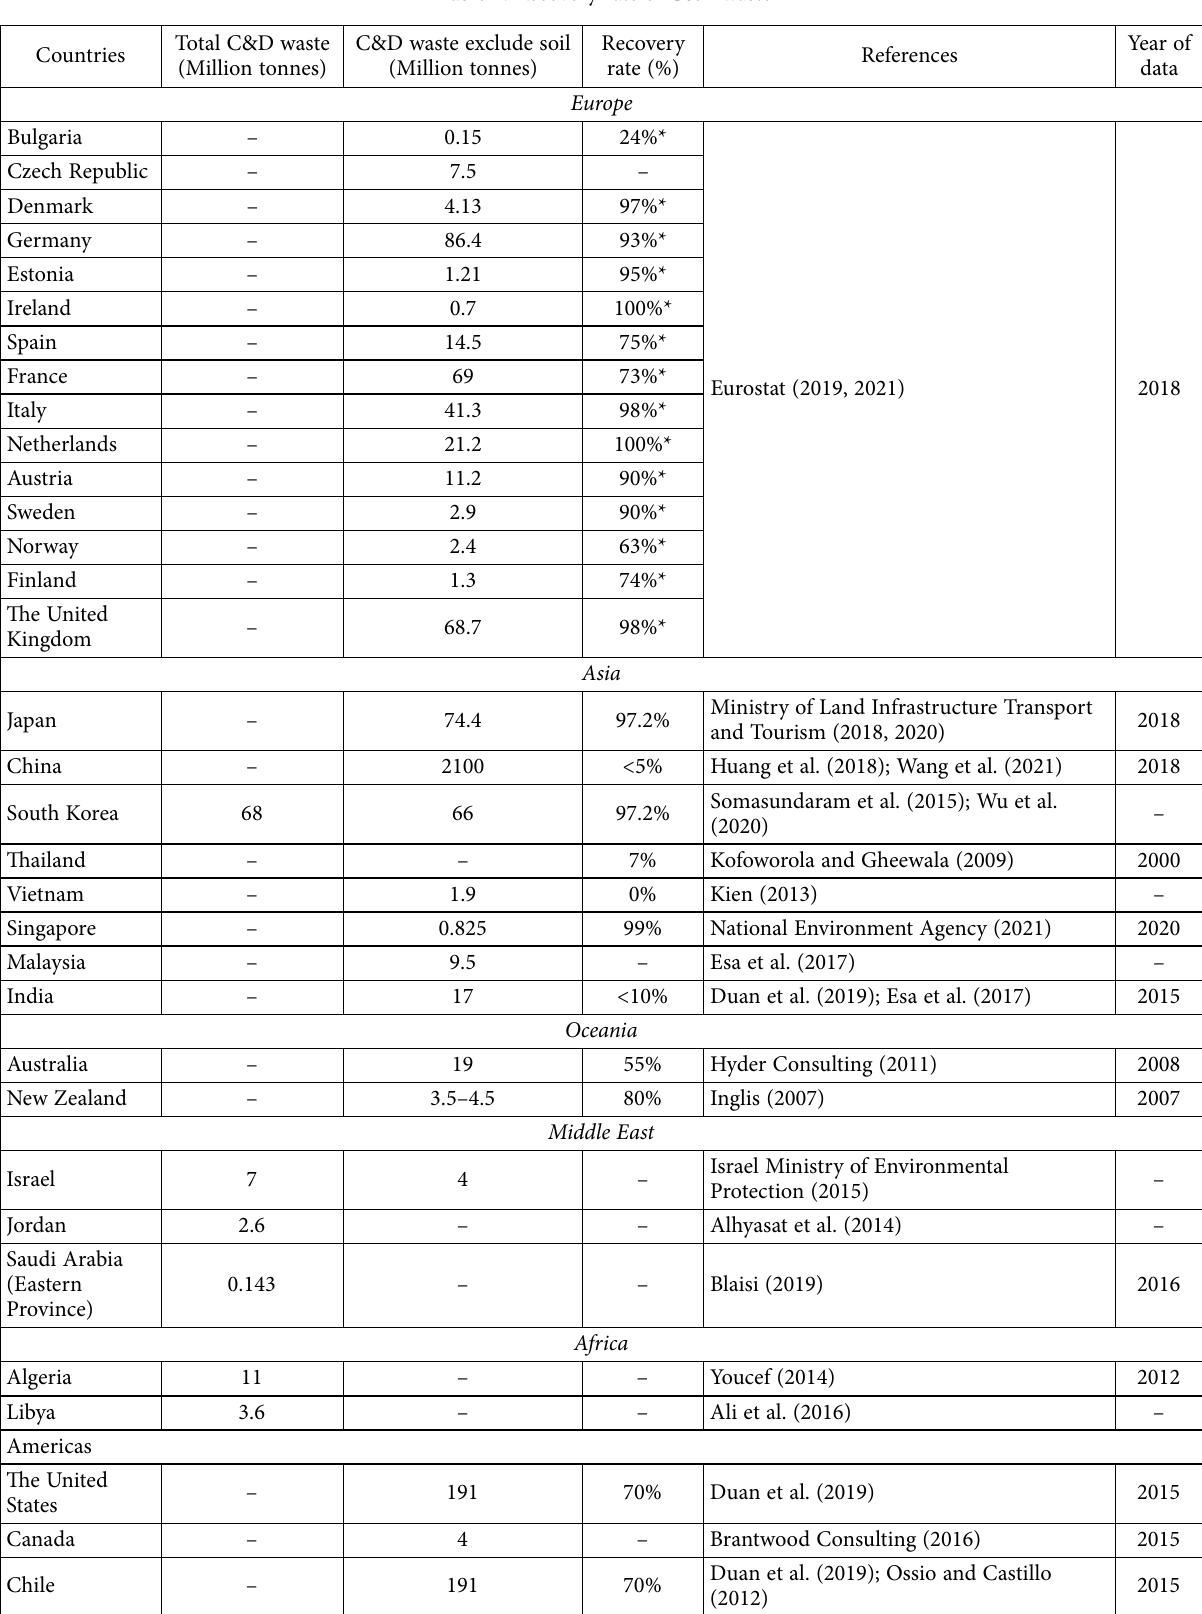
Table 2. Recovery rate of C&D